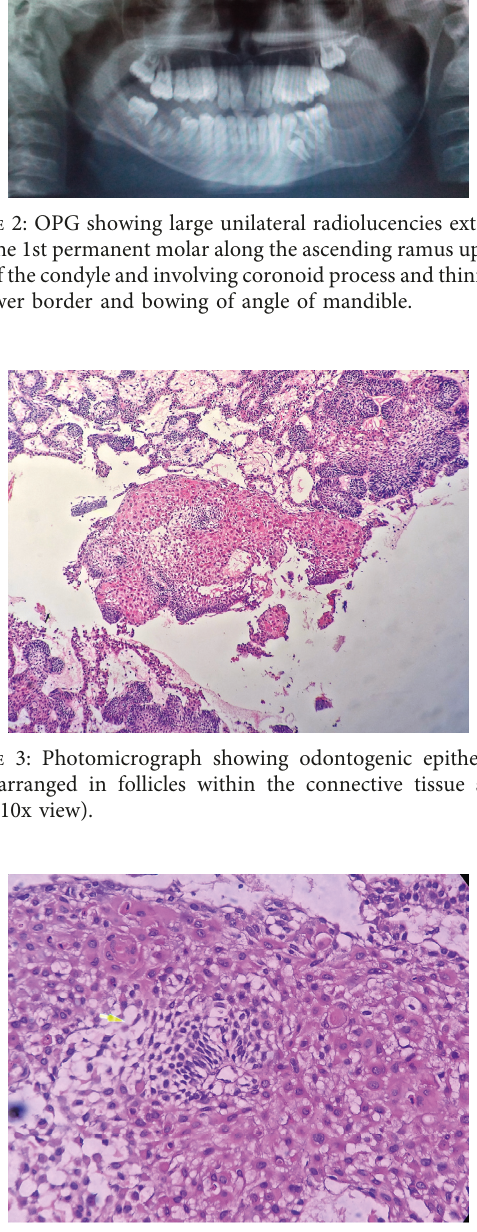
Figure 4: Photomicrograph showing areas of ameloblast-like cells, stellate reticulum-like cells, individual cell keratinisation, and squamous